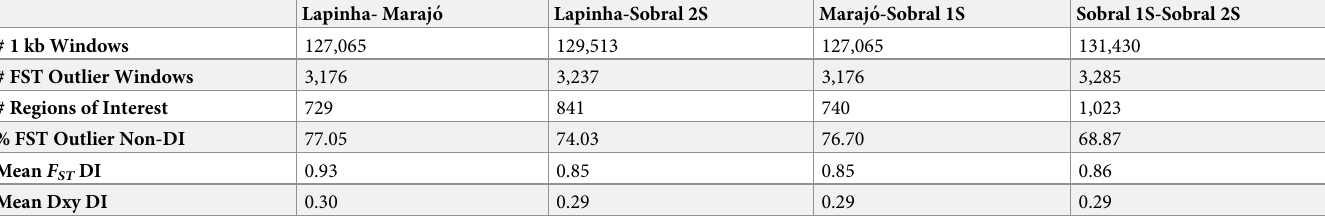
Fig 5. Measures of divergence in 1 kb non-overlapping genomic windows between the different populations of Lutzomyia longipalpis . (A) Box plots of D and F values in the top 2.5% quantile (outlier) of each population comparison. (B) Box plots of D xy ST having both high D xy and high F ST (differentiation islands). (C) Box plots of Tajimas’ D values for the differentiation islands. (D) Box plots of FLK values for sites within differentiation islands. Box plots show the medians (lines) and interquartile ranges (boxes); the whiskers extend out from the box plots to 1.5 times the interquartile range, and values outside this limit are represented by dots. Mean values are represented by open diamonds.